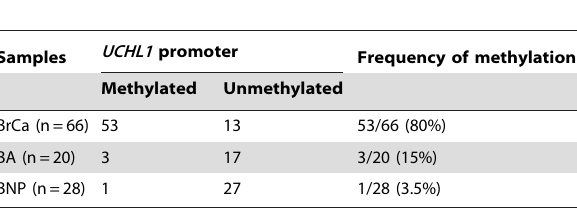
Table 1. Methylation status of the UCHL1 promoter in primary breast tumors.